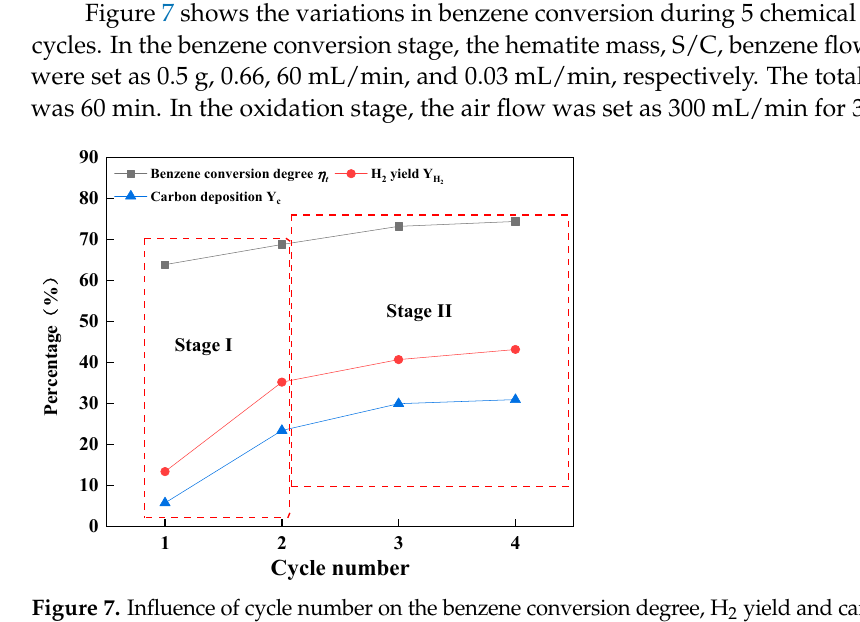
Figure 7. Influence of cycle number on the benzene conversion degree, H 2 yield and carbon deposi- tion.